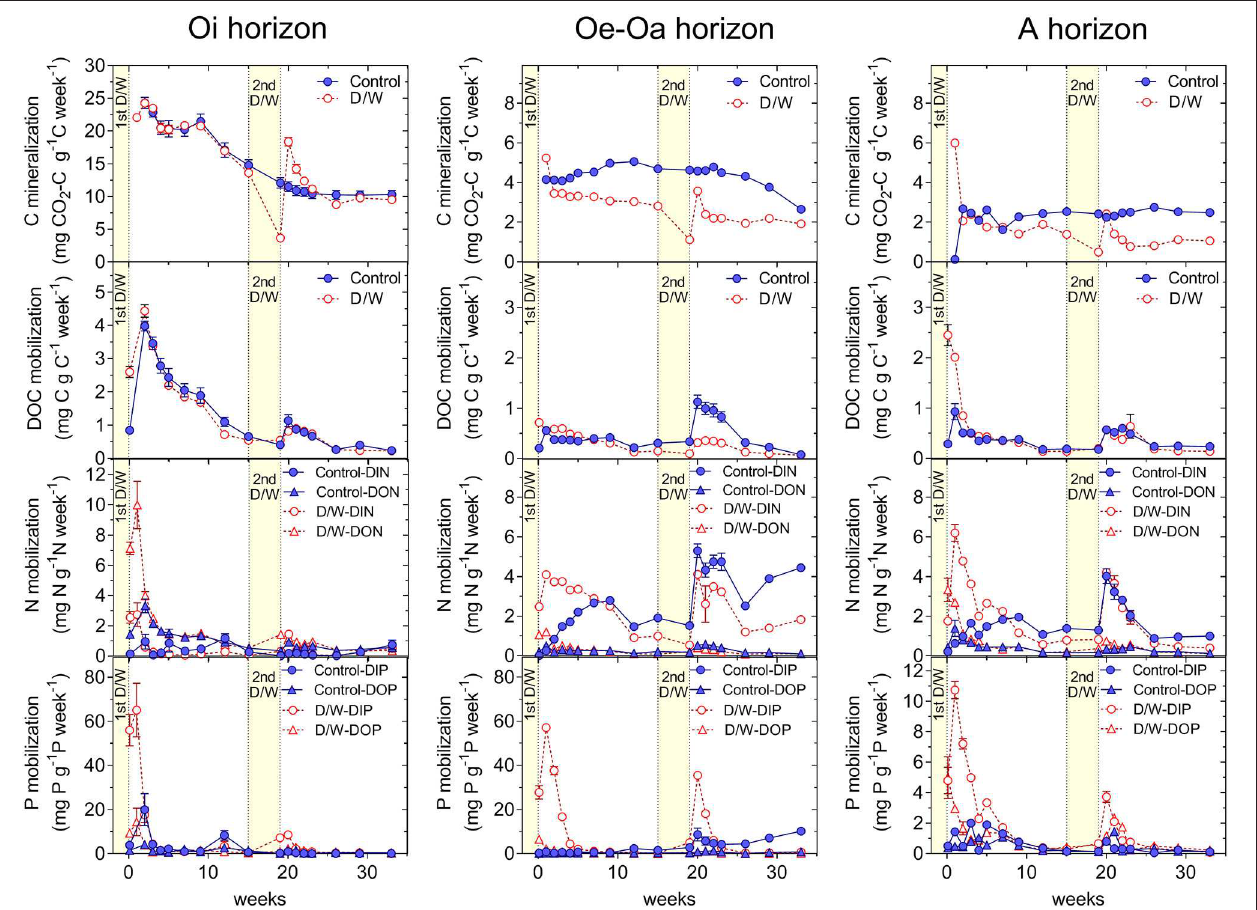
FIGURE 1 | Release of inorganic and organic carbon, nitrogen, and phosphorus from the Oi, Oe-Oa, and A horizons at the site Luess (LUE) over the course of the 33 weeks experiment. The drying-rewetting treatment consisted of two dry spells. Means and standard errors of four replicates per treatment. The D/W-treatment consisted of one short, harsh initial drying and a second moderate, 1 month-long drying.